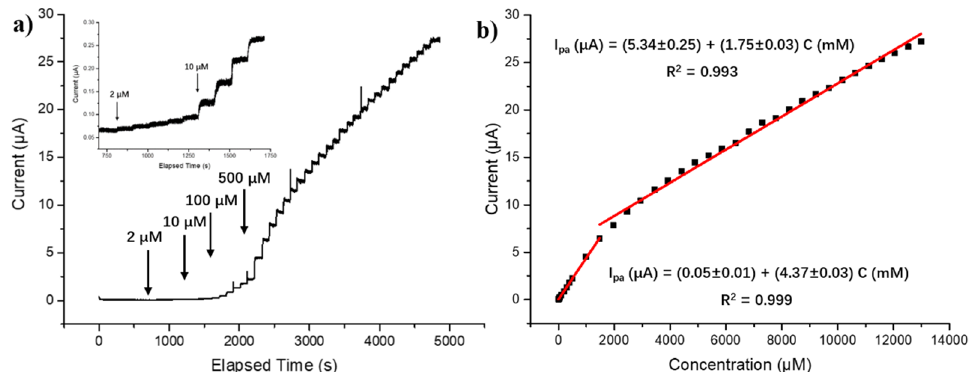
Figure 4. ( a ) The typical current–time dynamic response of the Fe@PCN-224/Nafion/GCE with successive additions of H 2 O 2 ranging from 2–13,000 μ M. Inset: enlarged current–time response curve with H 2 O 2 concentrations ranging from 2–50 μ M. ( b ) The linear relationship between current signal and H 2 O 2 concentration ranging from 2–1500 μ M and 1500–13,000 μ M. Table 1. Comparison of different sensors for the determination of H 2 O